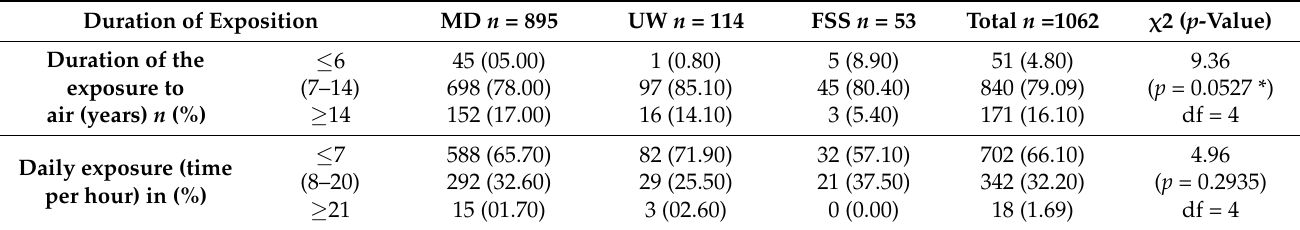
Table 2. Exposure to air pollution in the study